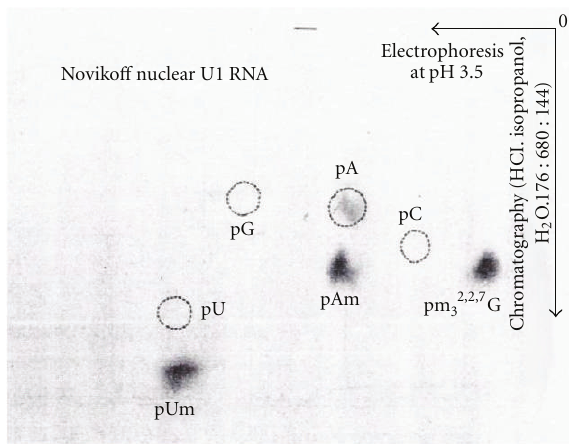
Figure 22: Nucleotide composition of U1 5 (cid:2) oligonucleotide [16]. The peak from the GTP region was digested with snake venom phosphodiesterase and separated on Whatman 3MM paper by electrophoresis at pH 3.5 (5% acetic acid adjusted pH to 3.5 with ammonium hydroxide) and chromatography in the second dimen- sion with a solvent system consisting of isopropyl alcohol, HCl, and H 2 O in the ratio of 680:176 :144 by volume. Autoradiography was performed using X-ray film.